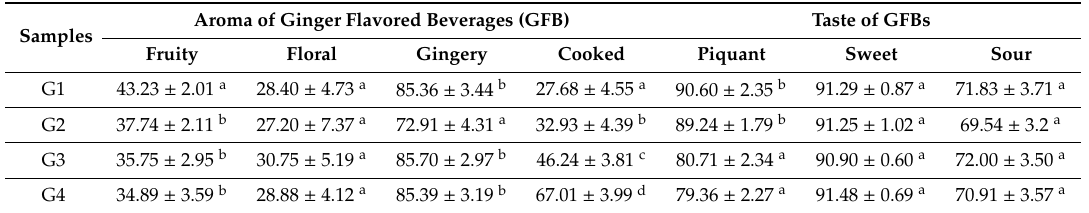
Table 7. Sensory evaluation analysis of ginger flavored